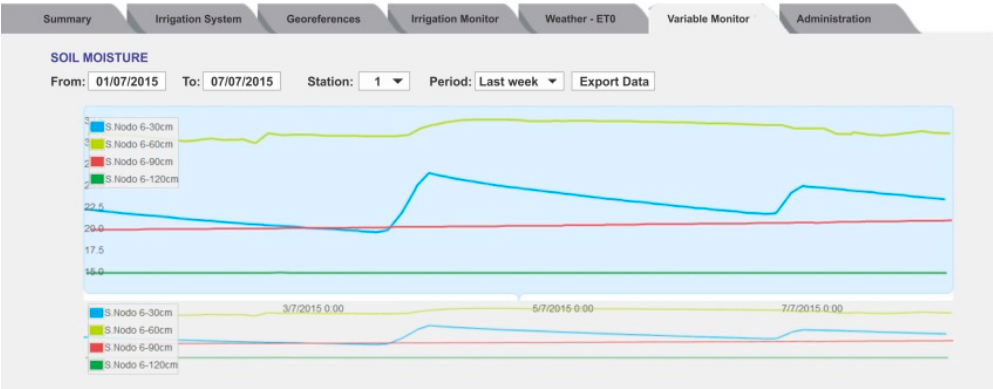
Figure 8. The Variables Monitor tab shows the soil moisture levels in a given period.